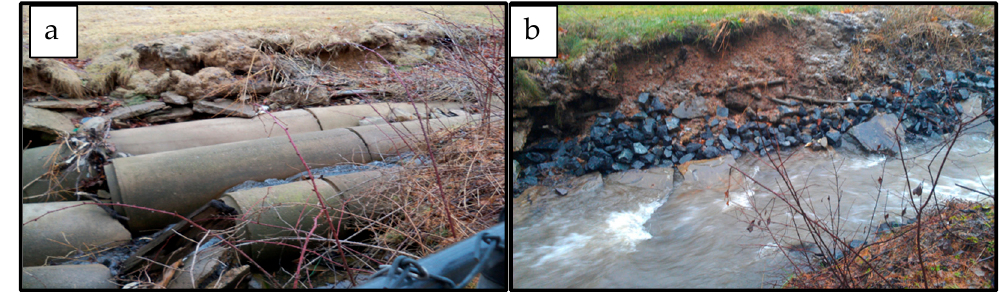
Figure 1. Cement culverts in a feeder brook that were visually assessed as a complete blockage to fish passage ( a ) pre-removal; and ( b ) post-removal .